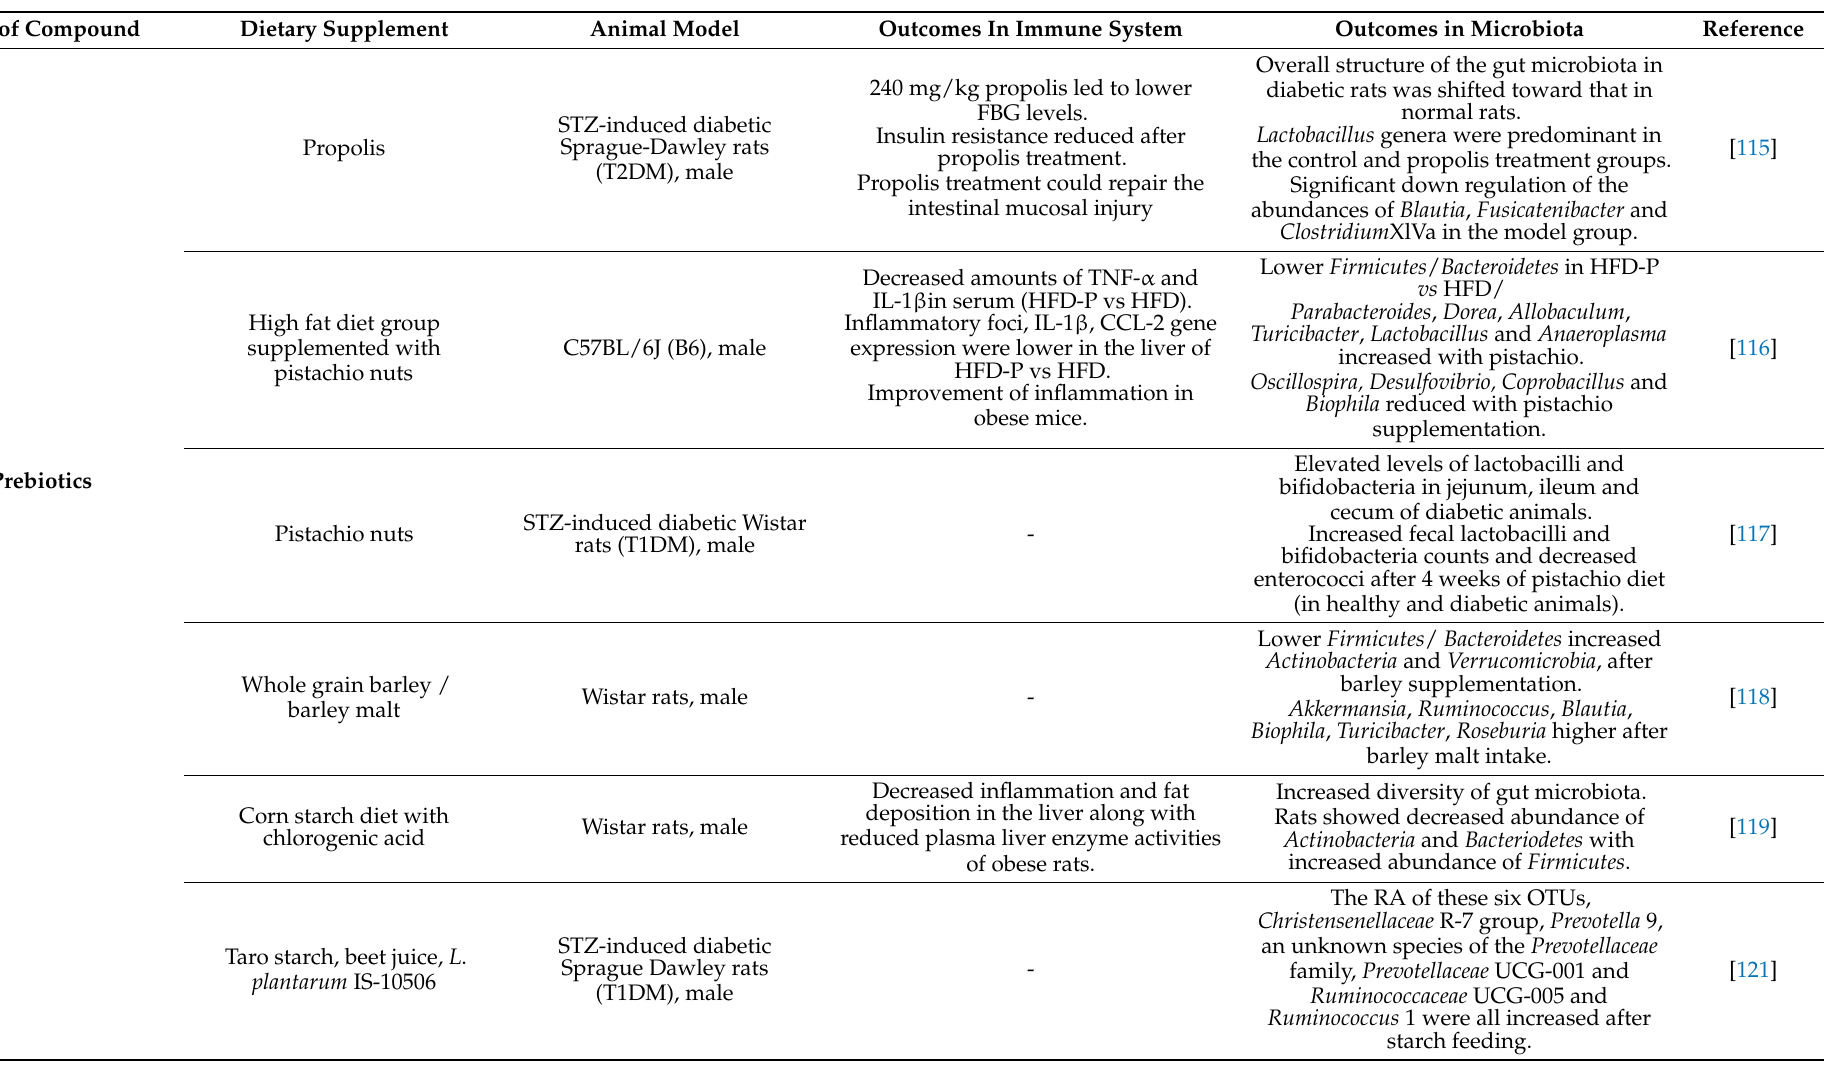
Table 1. Animal models supplemented with food ingredients; the main beneficial outcomes in the immunity system and the after-effect alterations in intestinal